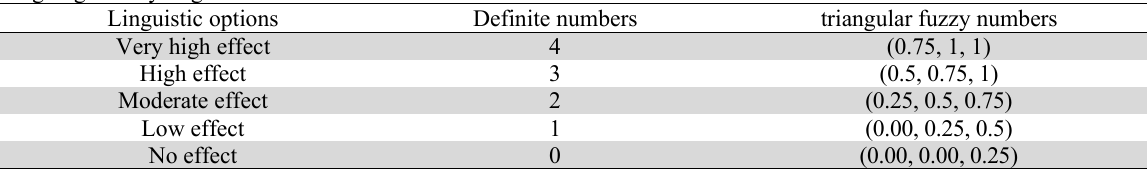
Designing a fuzzy linguistic